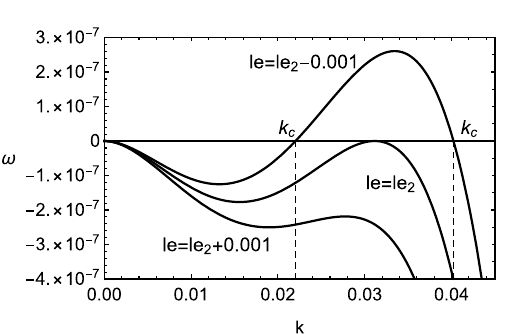
0.022, 0.0402 . 4.06 and k c ≈ ≈ −